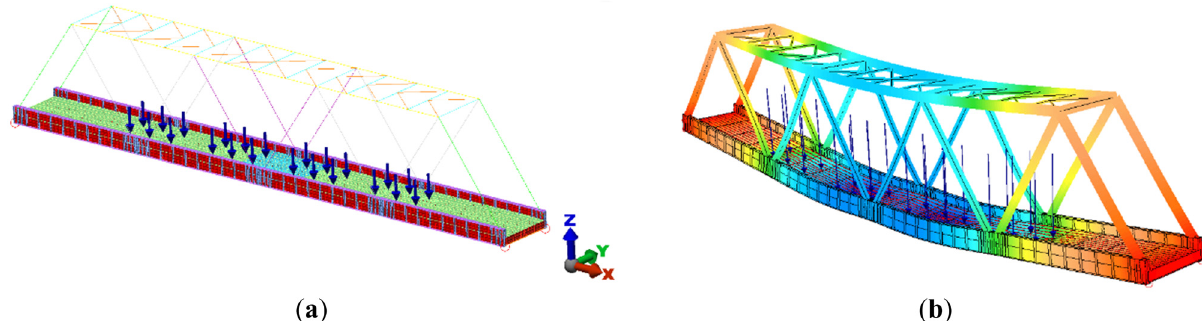
Figure 4: Static calculations of the plate - frame model: ( a ) the model with concentrated forces modelling the load of the wheels of locomotives ST43 and ST45 and ( b ) vertical displacements of the bridge caused by the weight of locomotives ST43 and